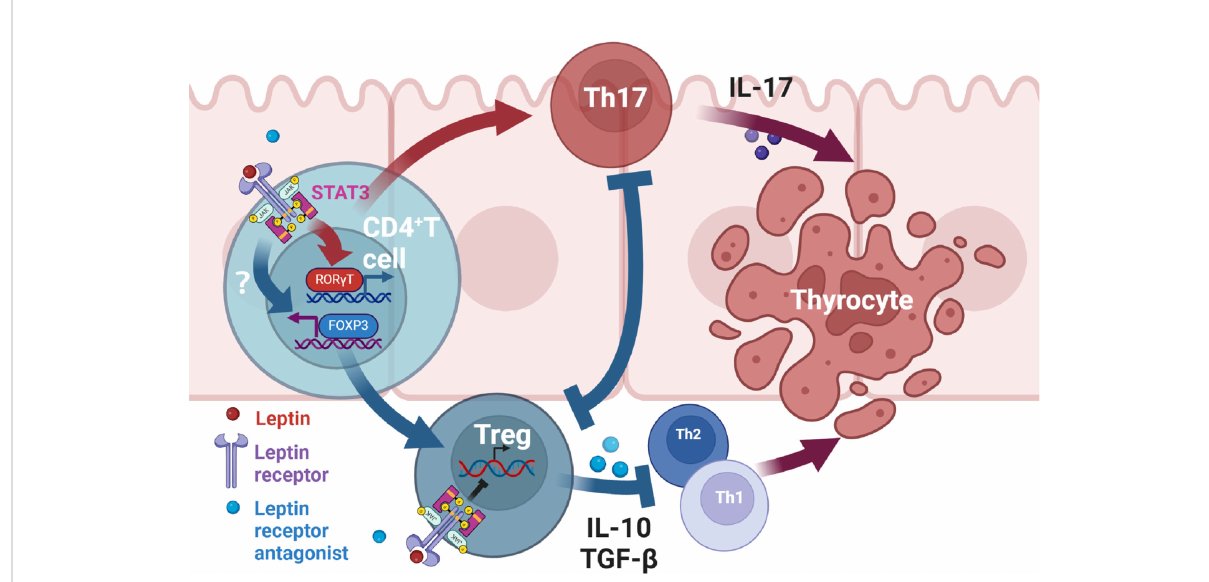
FIGURE 8 Mechanism of leptin receptor antagonists attenuating experimental autoimmune thyroiditis. Leptin binds to the leptin receptor (ObR) on the surface of T CD4+ lymphocytes, transmits signals to the nucleus through the JAK2/STAT3 pathway (47), promotes the transcription of ROR g t, and then promotes the differentiation of T CD4+ lymphocytes into Th17 cells. Th17 cells mediate downstream immune responses through the production of IL-17, thereby leading to apoptosis/necrosis of thyroid cells. Treg can alleviate in fl ammatory response by inhibiting Th1, Th2 and Th17 cells. Treg and Th17 cells have antagonistic developmental programs and the differentiation of Treg inhibits Th17 differentiation (43, 44). On the other hand, Allo-aca can also bind to ObR of Treg cells to maintain Treg proliferation (46). Therefore, leptin receptor antagonists alleviate thyroid cell apoptosis/necrosis in experimental autoimmune thyroiditis by inhibiting Th17 cell differentiation and promoting Treg differentiation and